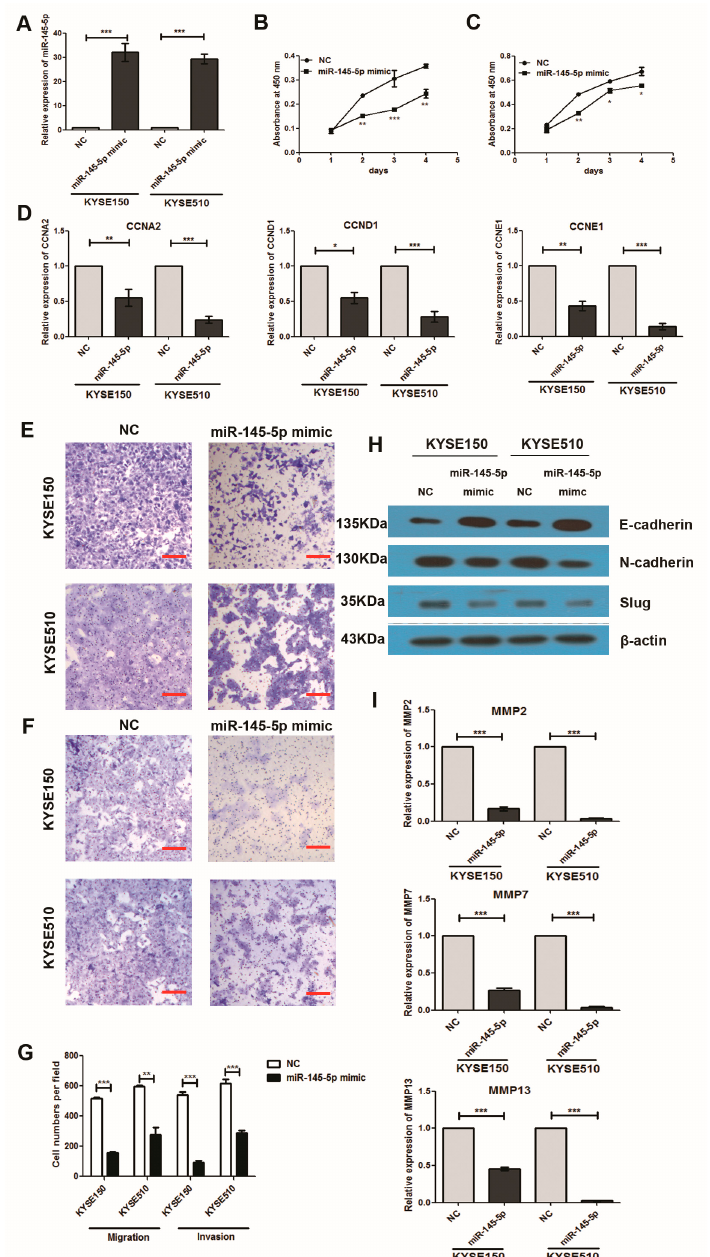
Figure 2. Overexpression of miR-145-5p suppressed ESCC cell proliferation, migration, invasion and epithelial to mesenchymal transition (EMT) of ESCC cells. ( A ) KYSE150 and KYSE510 cells were transfected with miR-145-5p mimics and a non-specific negative control for 48 h. The levels of miR-145-5p were determined by real-time PCR assay ( n = 3); ( B , C ) The cells were treated as indicated above, and the cell proliferation ability was determined by Cell Counting kit-8 (CCK-8) assay; ( D ) The mRNA levels of CCNA2 , CCND1 and CCNE1 were determined by real-time PCR assay ( n = 3); ( E – G ) Cell migration and invasion were detected using Transwell assay. Images of migration and invasion are presented ( n = 3), the bars represent 200 µm; ( H ) The protein expressions of Slug, E-cadheirn and N-cadherin were measured by Western blotting assay ( n = 3); ( I ) The mRNA expressions of MMP2 , MMP7 and MMP13 were determined by real-time PCR ( n = 3). NC: non-specific negative control. Three independent experiments were performed. MMP: matrix metalloproteinase. * p < 0.05; ** p < 0.01; *** p < 0.001.